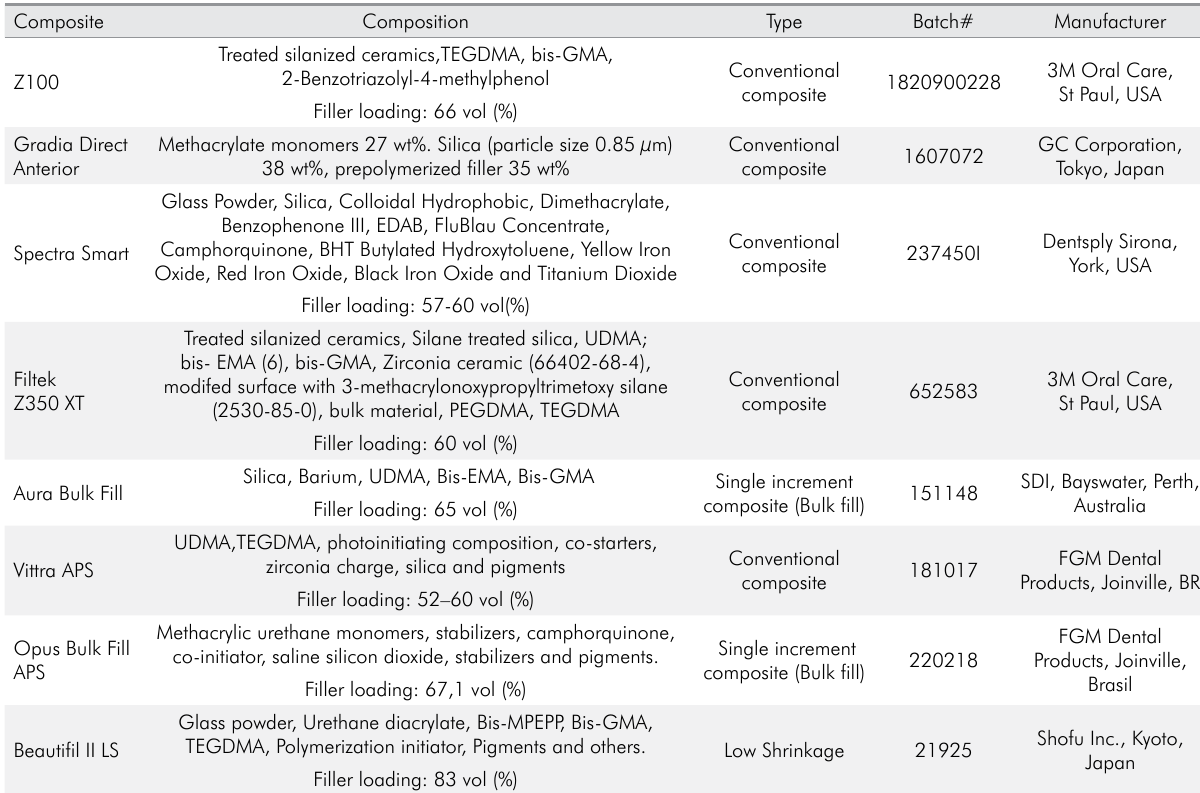
Table 1. Material information.